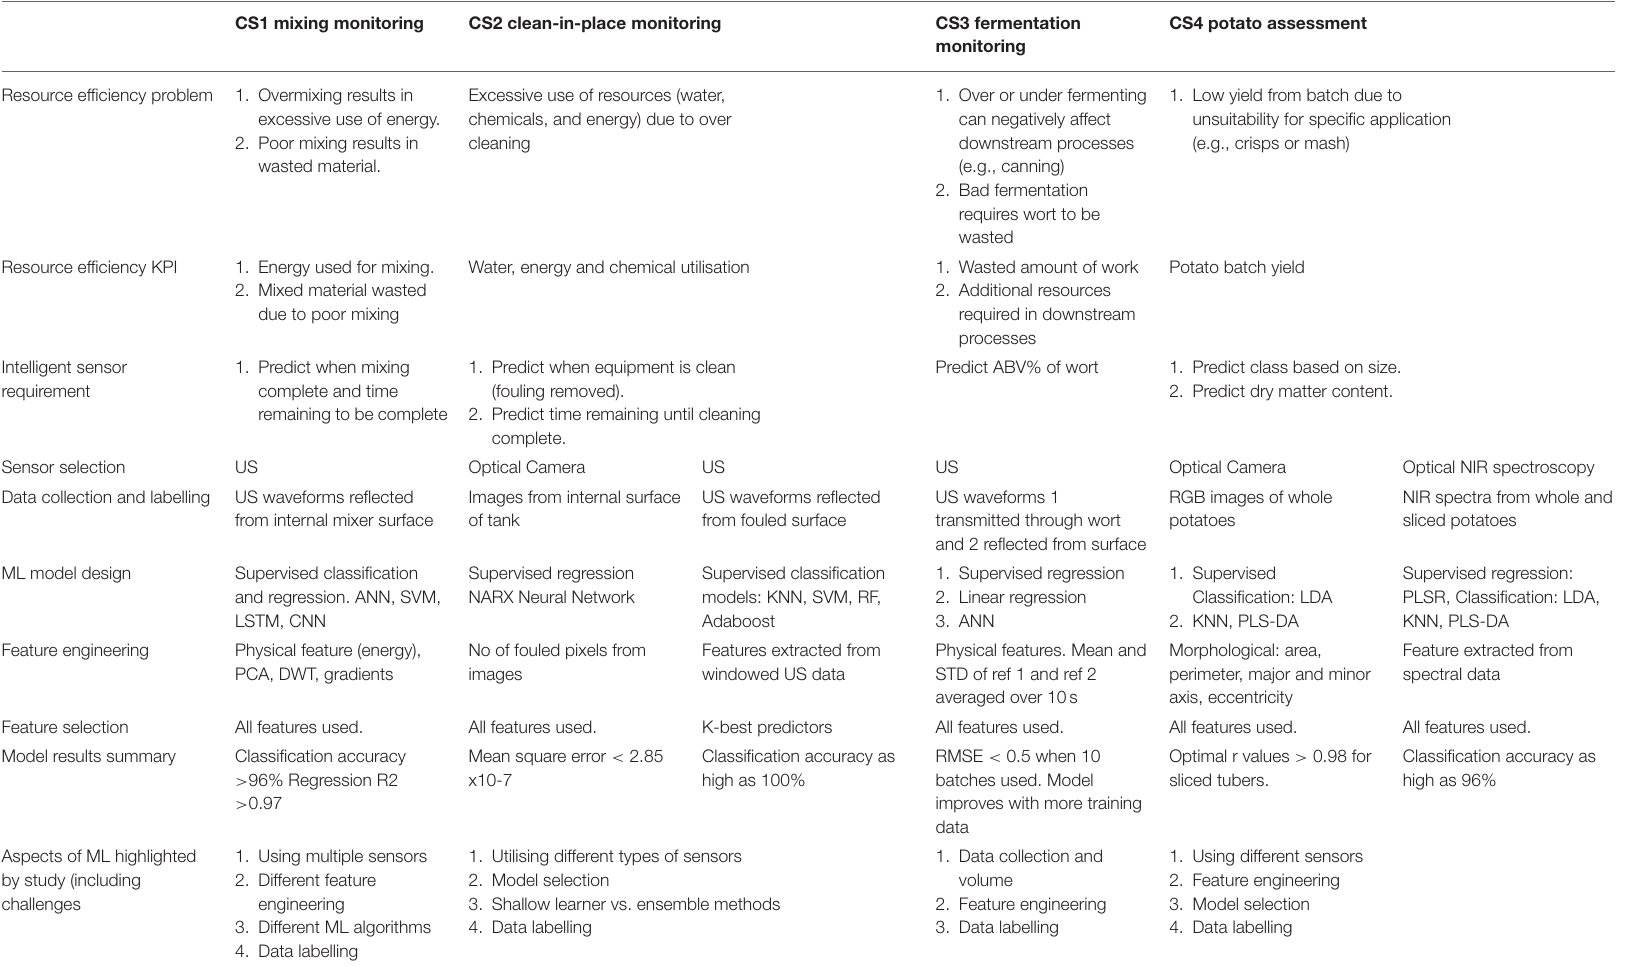
TABLE 1 | Key features of the four intelligent sensing case